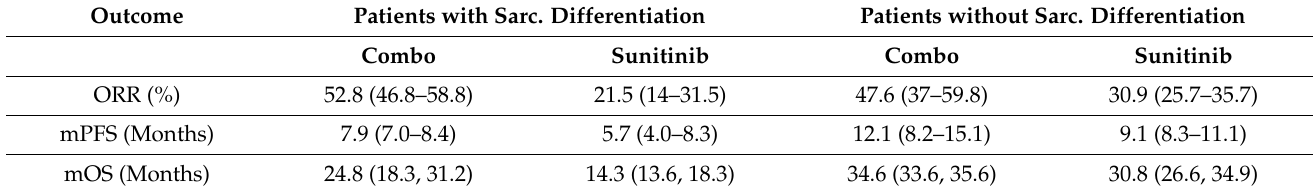
Table 2. Summary of objective response rate (ORR), median progression-free survival (mPFS), and median overall survival (mOS) of ccRCC patients with and without sarcomatoid differentiation treated with a combination of biologically targeted molecules vs. sunitinib [1], ( ): range. Outcome Patients with Sarc. Differentiation Patients without Sarc.